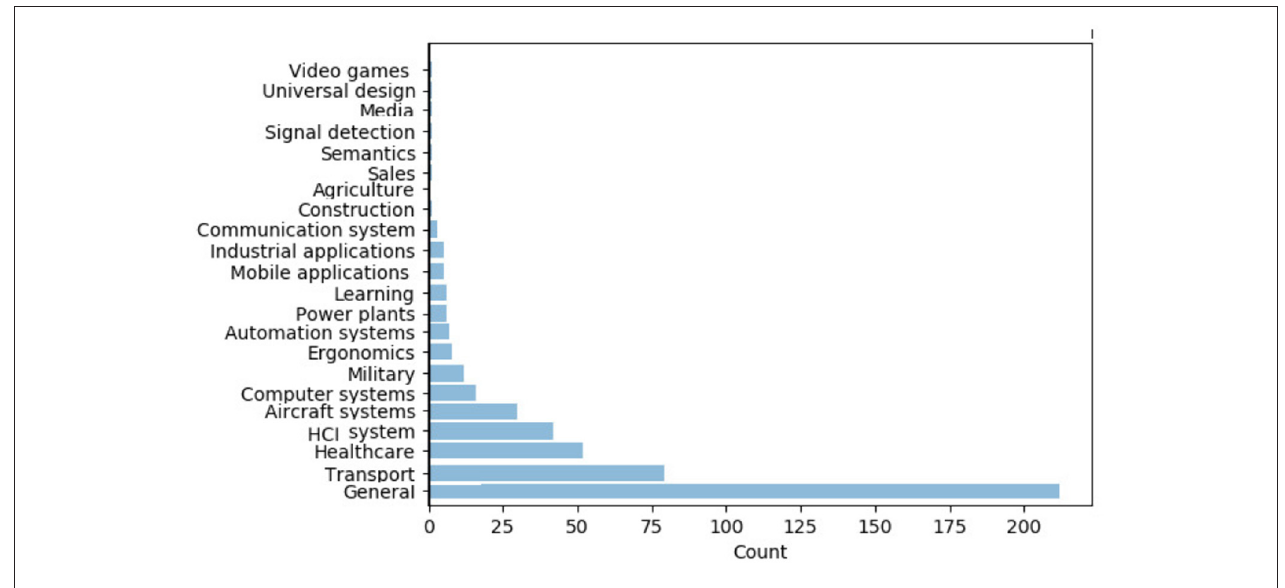
FIGURE 6 | Distribution of the articles by domain of application.